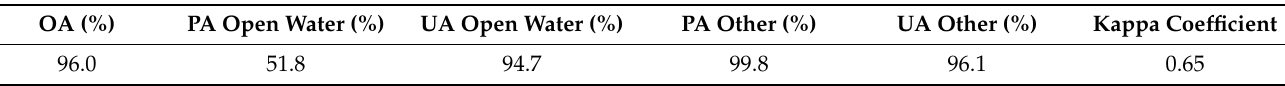
Figure 8. Flood extent detected by the developed solution (in red) from Sentinel-1 images acquired on 29 October and on 2 November, 2018. Manually digitized flood extent (in blue) from a Sentinel-2 image acquired on 31 November 2018. The western part of the area selected for the flood event in Austria, 2018. Source of background map: Open Street Map (OSM). Table 2. Statistical evaluation of comparison between flood extent detected by developed solution and digitized from Sentinel-2 imagery for the Austria, 2018 flood